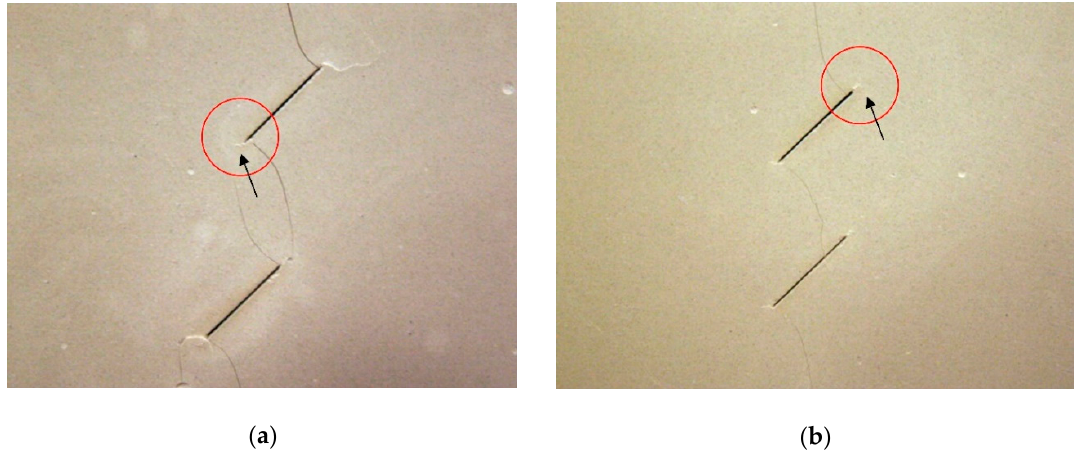
Figure 19. Example of fatigue cracks. ( a ) Horizontal fatigue cracks. ( b ) Colinear fatigue cracks.